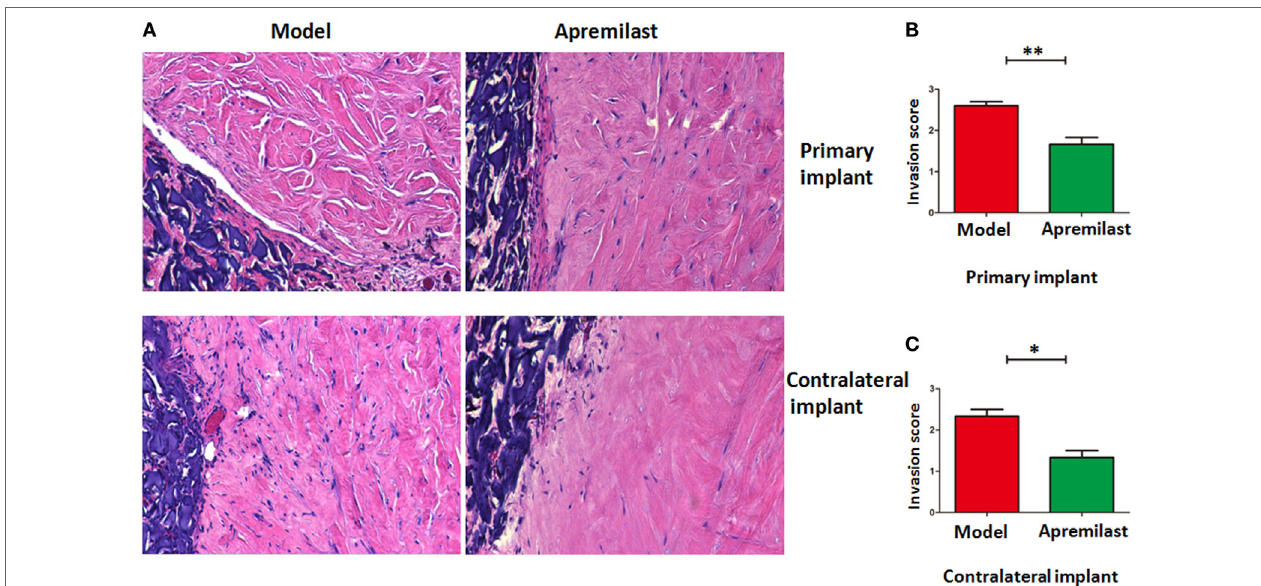
FigUre 6 | Apremilast treatment inhibited rheumatoid arthritis (RA) synovial fibroblast (RASFs) from migrating and destroying cartilage in the humanized animal model. Sponge-cartilage complex, containing cartilage with synovial fibroblasts from RA patients (RASFs), was implanted into the flank skin of a severe combined immunodeficiency (SCID) mouse (primary implant). We also inserted cartilage without RASFs under the skin of the contralateral flank (contralateral implant). After the humanized synovitis model was established, Apremilast (25 mg/kg, oral, once daily) was given to SCID mice for 10 continuous days. We removed the implants for evaluation after 60 days. Invasion scores are classified as the previous report. (a) Apremilast treatment can inhibit the ability of RASFs from migrating to and destroying cartilage. (B,c) Compared with the model group ( n = 6), Apremilast treatment ( n = 6) significantly reduced the invasion scores in both primary implant and contralateral implant. The data indicate the mean ± SEM from two independent experiments (* p < 0.05, ** p < 0.01). Data were analyzed using unpaired t -tests